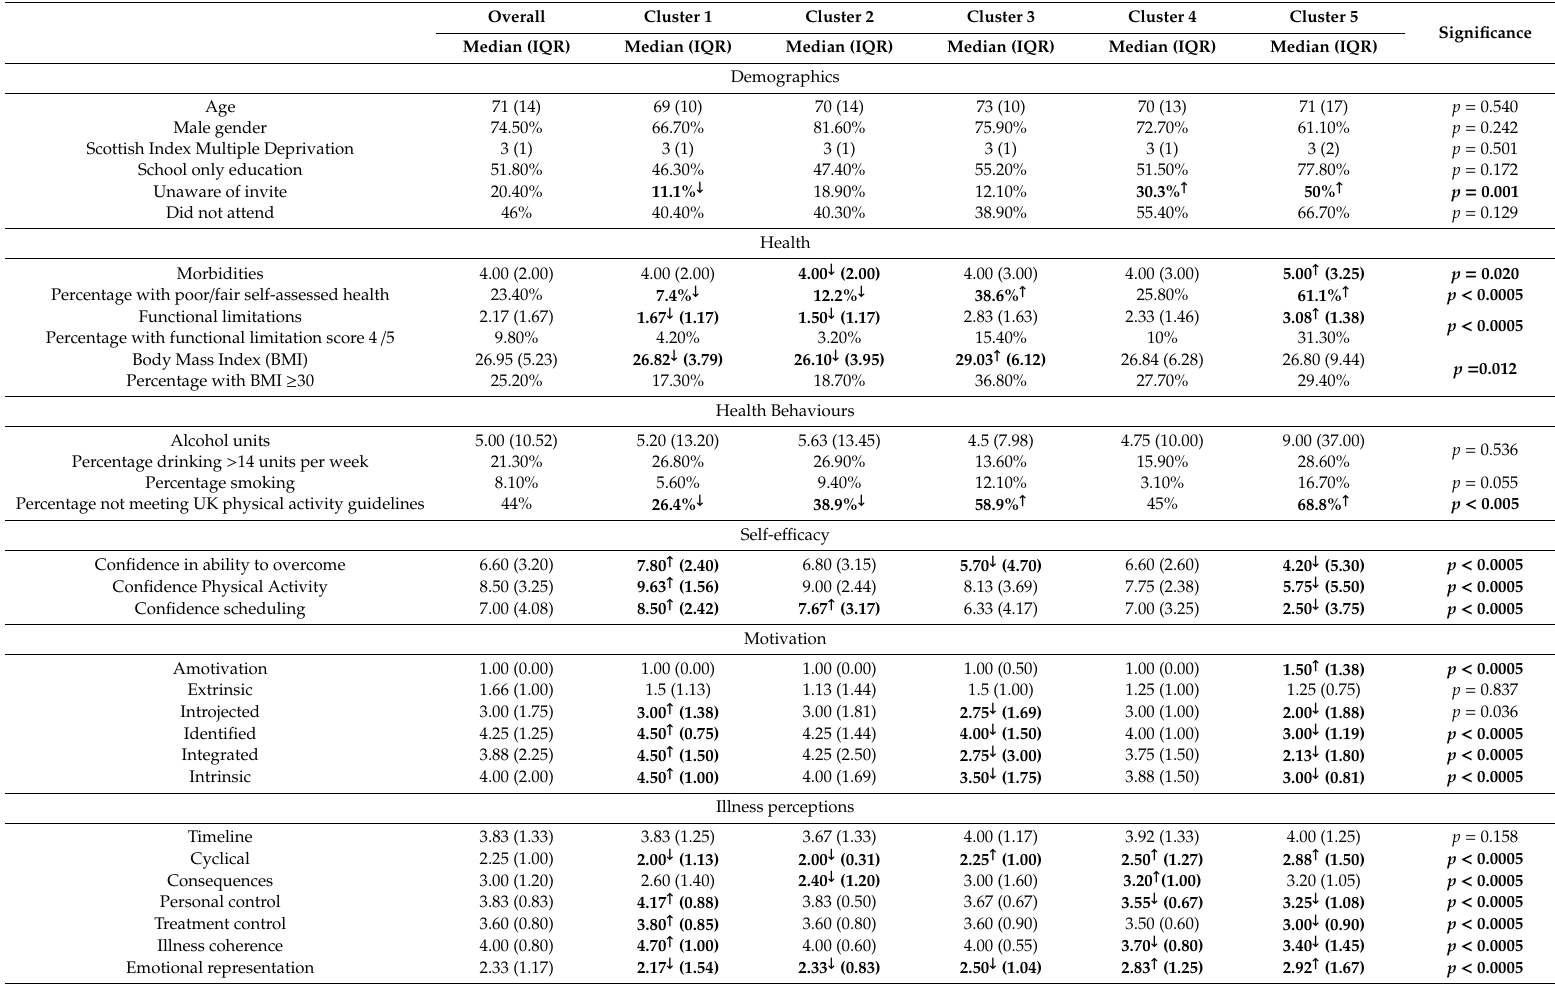
Table 4. Sample and cluster medians for health, behaviour and psychological